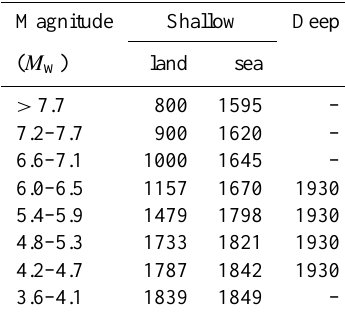
Table 2. Reference years for different magnitudes and types of events.